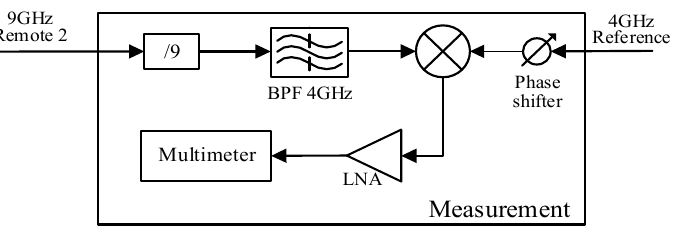
Figure 5. Stabilities measurement scheme; LNA: low-noise amplifier; BPF: band pass filter.